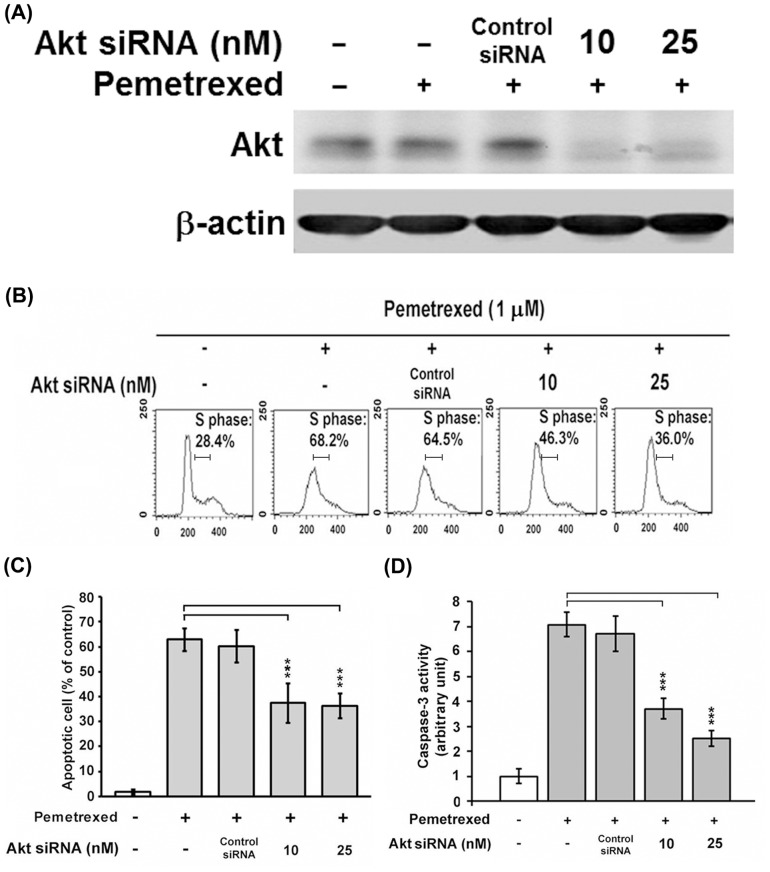
Knockdown of Akt by siRNA diminishes pemetrexed-induced S-phase arrest and apoptosis.Cells were transfected with 10 and 25-specific siRNA or scrambled siRNA for 16 h, and then incubated with 1 µM pemetrexed for 24 h; (A) the expression levels of Akt, and (B) cell cycle distribution were examined. (C) Apoptotic cells and (D) caspase-3 activity were assessed after 72 h pemetrexed treatment. ***P<0.001.